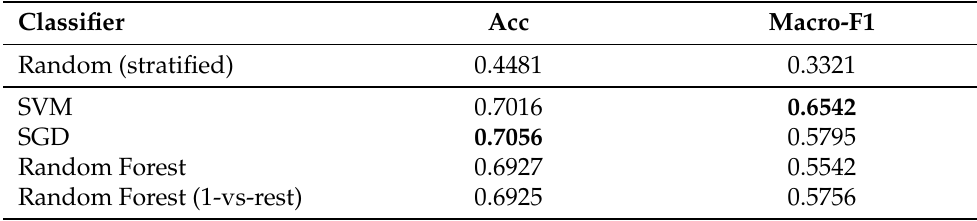
Table 7. Results obtained using the base techniques for infraction severity